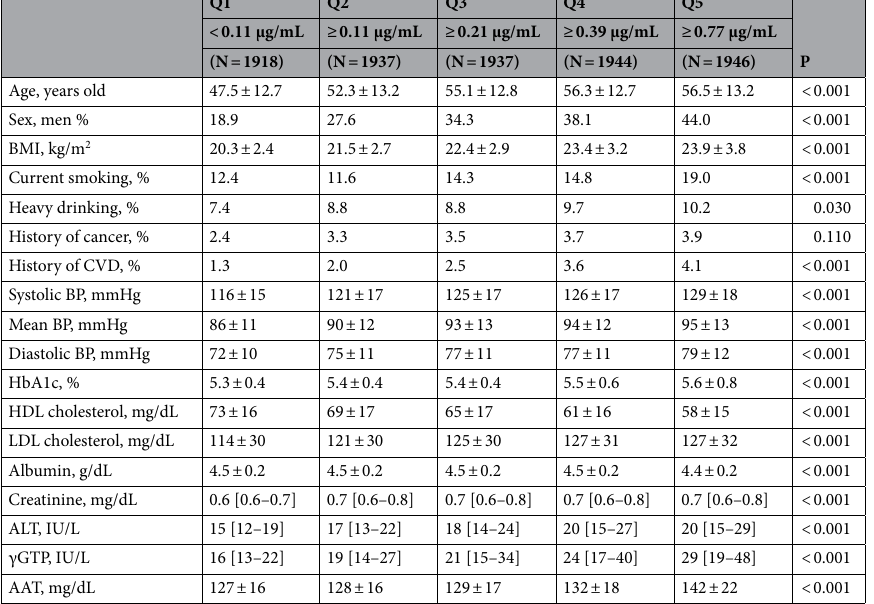
Table 2. Baseline clinical characteristics of the study participants by high-sensitivity hsCRP level quintile (N = 9682). Values are represented as the mean ± standard deviation, median [interquartile range], or frequency. Numbers of study participants in each quintile are shown in parentheses. Statistical significance was assessed by analysis of variance, Kruskal–Wallis test, or a Chi-squared test. Cardiovascular diseases (CVDs) include symptomatic stroke, angina pectoris, and myocardial infarction. AAT α1-antitrypsin, BMI body mass index, BP blood pressure, HbA1c hemoglobin A1c, HDL high-density lipoprotein, LDL low- density lipoprotein, ALT alanine aminotransferase, γGTP gamma-glutamyltransferase, hsCRP high-sensitivity C-reactive protein.